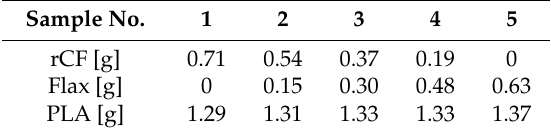
Table 2. Fibre weight compositions for one layer of each sample produced.